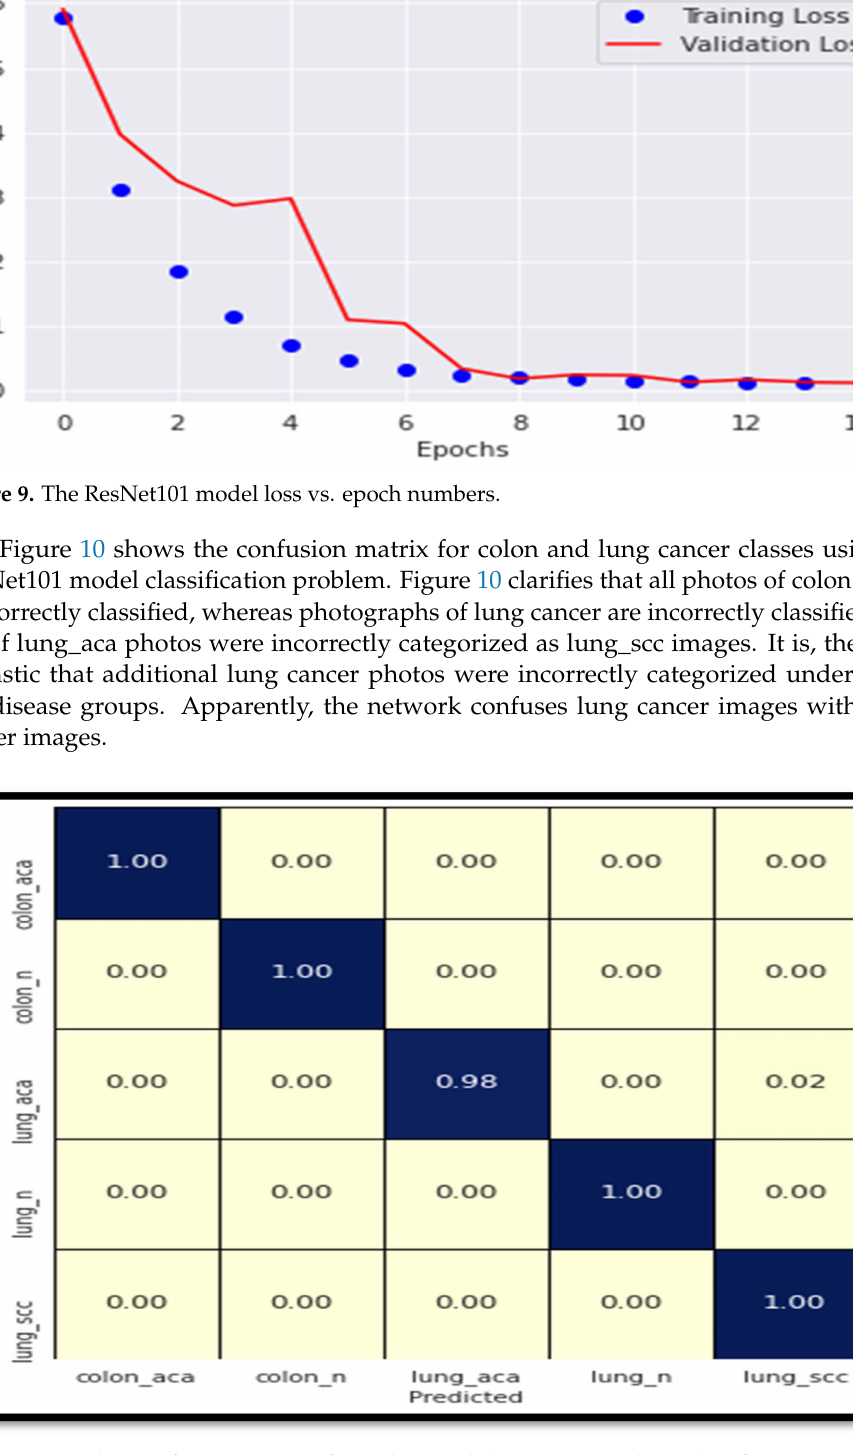
Figure 10. The confusion matrix for colon and lung cancer class classification using the ResNet101